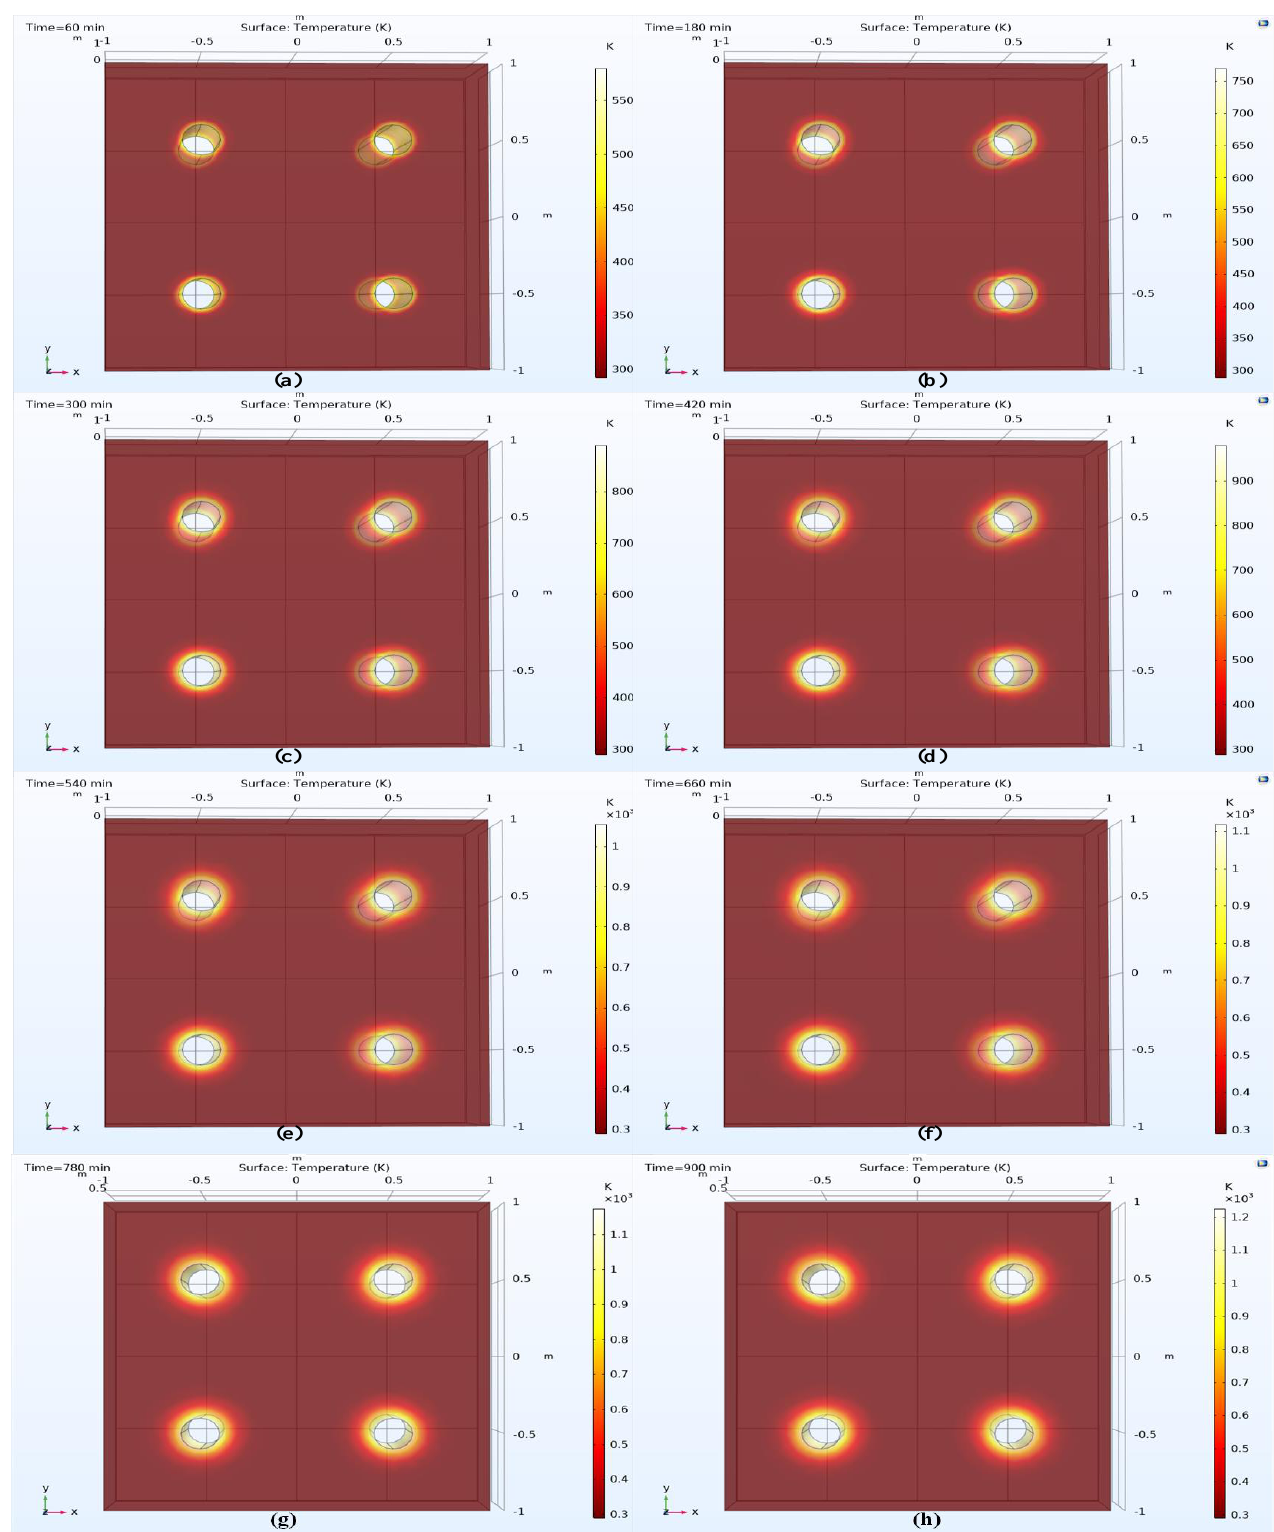
Figure 5. Temperature field distribution in the porous media model in 1~15 h. Subfigures ( a – h ) show the temperature field distribution of porous media every two hours after the first hour of simulation. The temperatures represented by different colors are given in the legend.